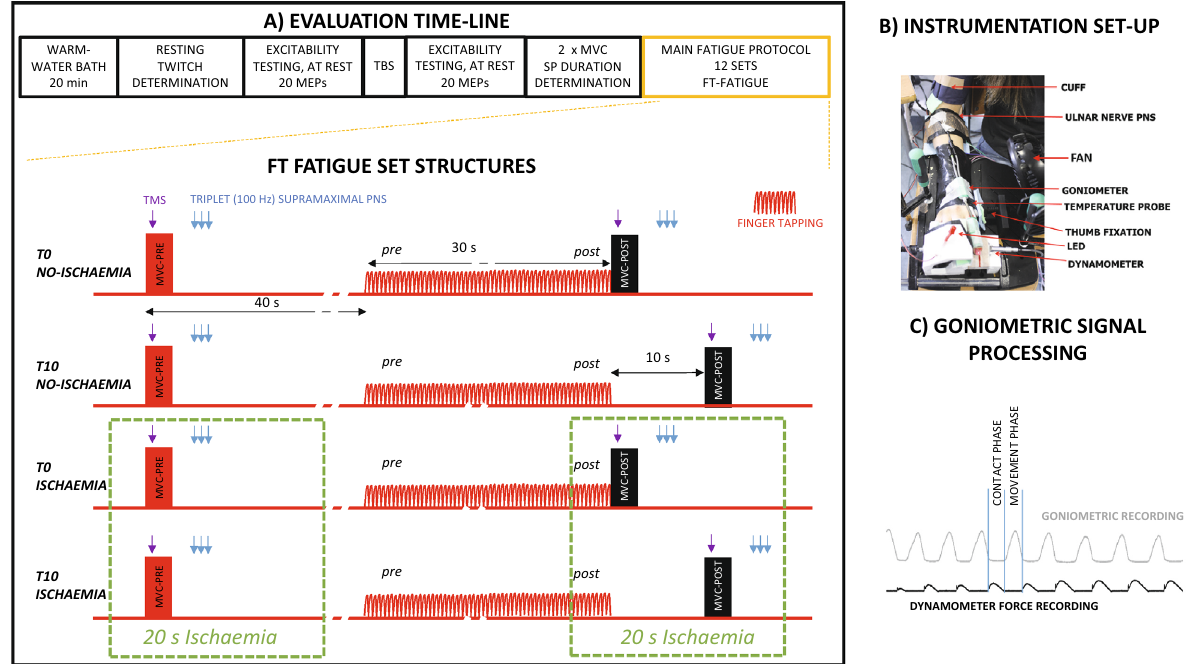
Figure 1. Protocols used for FT fatigue testing. ( A ) Evaluation timeline and structure of FT fatigue testing conditions: after soaking the hand and forearm in a warm-water bath for 20 min, we determined the intensity of percutaneous electrical stimulation needed to acquire muscle resting twitches. Then, using paired-pulse TMS over M1, we tested corticospinal excitability with motor evoked potential (MEP) amplitudes and long intracortical inhibition (LICI). Next, we applied M1 theta-burst stimulation (TBS; intermittent [iTBS], continuous [cTBS] and sham [shamTBS] across different sessions, on different days), and MEP and LICI were retested. Each day, after receiving TBS, subjects performed two brief MVCs (with 3 min rest between) to determine the M1-TMS intensity to be used in the fatigue protocol; this was the intensity needed to produce SP durations of ≈ 200 ms in the two MVCs. Subsequently, subjects performed 12 FT sets (four different set- conditions sequentially repeated three times) with 3 min rest between every set. The T0 NO-ISCHAEMIA condition started with a brief MVC (PRE) in response to a light-emitting diode (LED) turning on. At the MVC plateau, muscle force was recorded, and TMS was delivered to acquire SP; 500 ms after the TMS pulse, the LED turned off as a cue to stop the MVC. Three seconds later, and with the muscle at rest, we applied percutaneous nerve stimulation (a triplet at supramaximal intensity) to produce a resting muscle twitch. With this twitch, we calculated the HRT of the muscle offline. Next, 40 s after the sequence of events had started, subjects executed FT at the maximal possible rate for 30 s. Immediately after FT (with no gap), subjects performed another brief MVC (POST), and stimulations were applied as before. The remaining conditions were similar to those described above, with small differences. For T10 NO-ISCHAEMIA , the MVC POST FT (and stimulation) started after a delay of 10 s following the end of FT; during the delay, subjects remained at rest. For the ischaemia conditions ( T0 ISCHAEMIA and T10 ISCHAEMIA ), the sets were as above but had 20 s of muscle ischaemia at the time of stimulation testing. ( B ) Instrumentation and set-up: the different units are indicated by arrows in the panel. The apparatus was worn by the subjects immediately after removing their arms from the water bath. ( C ) Signal processing: this method was used to determine the features of the tapping profile, as described in detail in the “Methods” section.